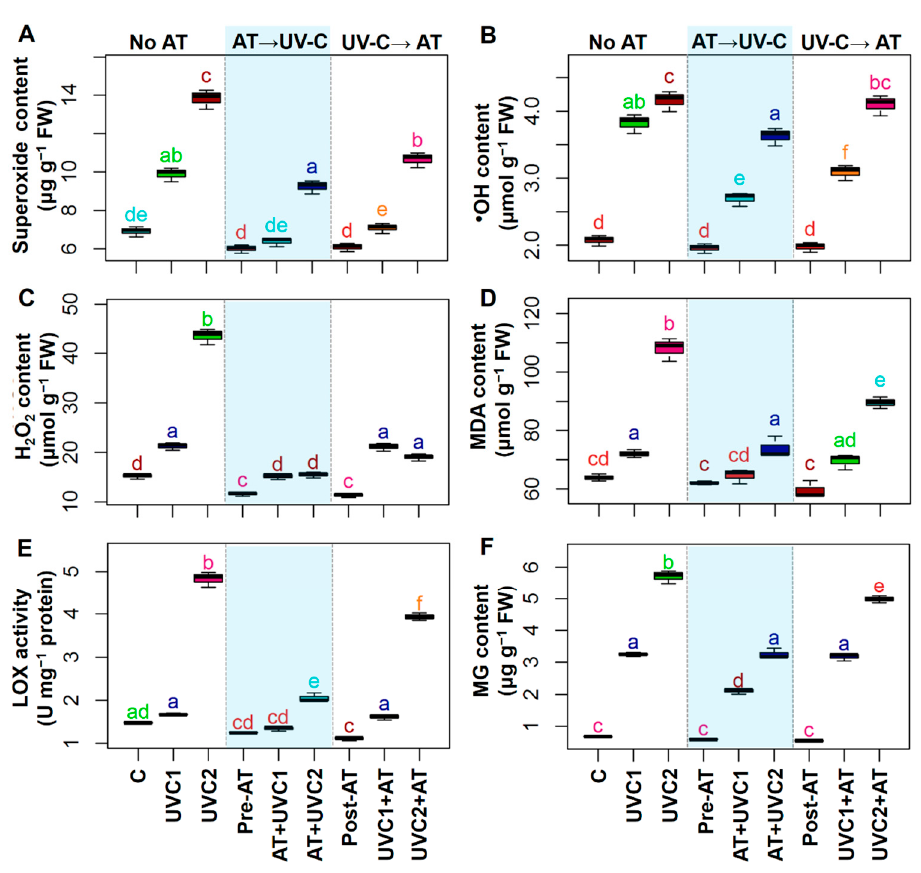
Figure 2. Effects of pretreatment and post-treatment of allantoin (AT) on the superoxide anion (O 2• − ) content ( A ), hydroxyl radical ( • OH) content ( B ), hydrogen peroxide (H 2 O 2 ) content ( C ), malondialdehyde (MDA) content ( D ), lipoxygenase activity (LOX) ( E ), and methylglyoxal (MG) content ( F ) in tomato plants grown 15 days in presence and absence of UVC stress. Each boxplot shows values of five independent replicates ( n = 5). Boxplots specified with the same letter(s) are statistically non-significant at p < 0.05 based on Tukey’s test. Treatments are the same as Figure 1. 2.5. AT Improved Non-Enzymatic Antioxidant Status and Secondary Metabolites Exposure of tomato plants to UVC stress displayed a sharp increase in GSH content and flavonoid content but showed a significant decrease in anthocyanin content and TPC in ”UVC1” and ”UVC2” plants relative to that observed in ”C” plants (Figure 3A,C–F). Total AsA contents in ”UVC1” plants significantly increased, whereas α -tocopherol con- tent displayed a non-significant change in ”UVC1” and ”UVC2” plants relative to that observed in ”C” plants (Figure 3B,E). Pre-treatment of AT significantly increased GSH content and flavonoid content in ”AT+UVC1” plants but increased AsA, anthocyanin, α - tocopherol, and TPC contents in ”AT+UVC1” and ”AT+UVC2” plants compared to that found in the corresponding ”UVC1” and ”UVC2” plants (Figure 3). Post-treatment of AT also significantly improved GSH and AsA content in ”UVC1+AT” and ”UVC2+AT” plants and flavonoid content in ”UVC1+AT” plants compared to that found in the corresponding ”UVC1” and ”UVC2” plants (Figure 3A,B,D).